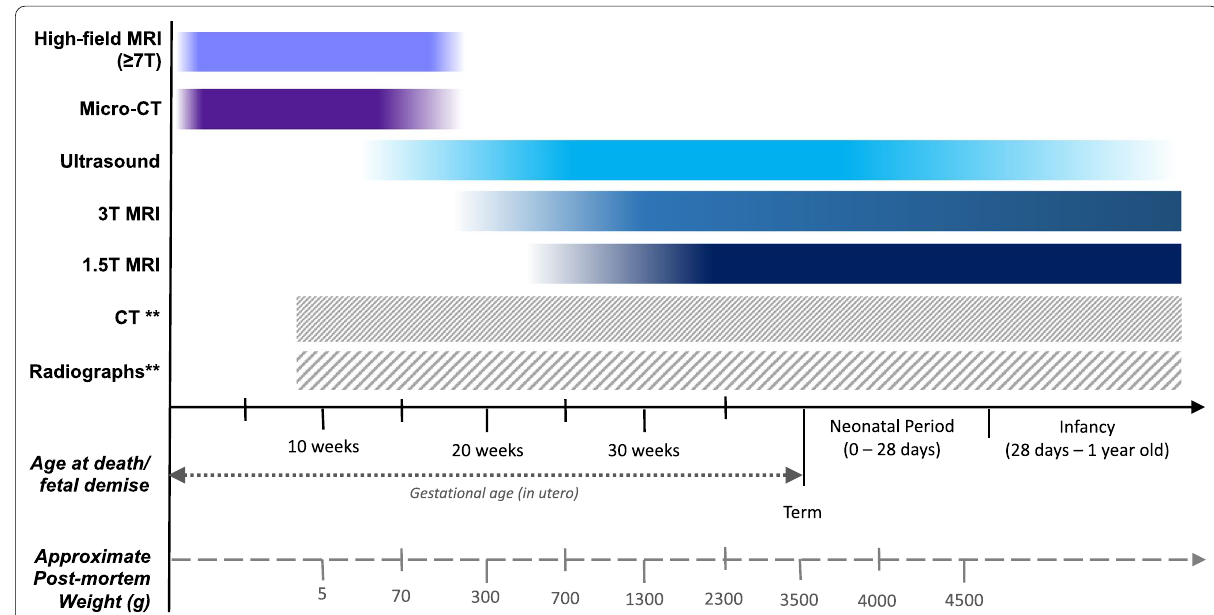
Fig. 3 Typical estimated gestational ages and post-mortem weights where various post-mortem imaging modalities could be used to provide diagnostic quality examinations. ** Technically, radiographs and CT can be performed at any age after 8-week gestation (when the foetal skeleton beings to ossify), but in practice they are best reserved for specific clinical situations, such as for suspected skeletal abnormalities or trauma